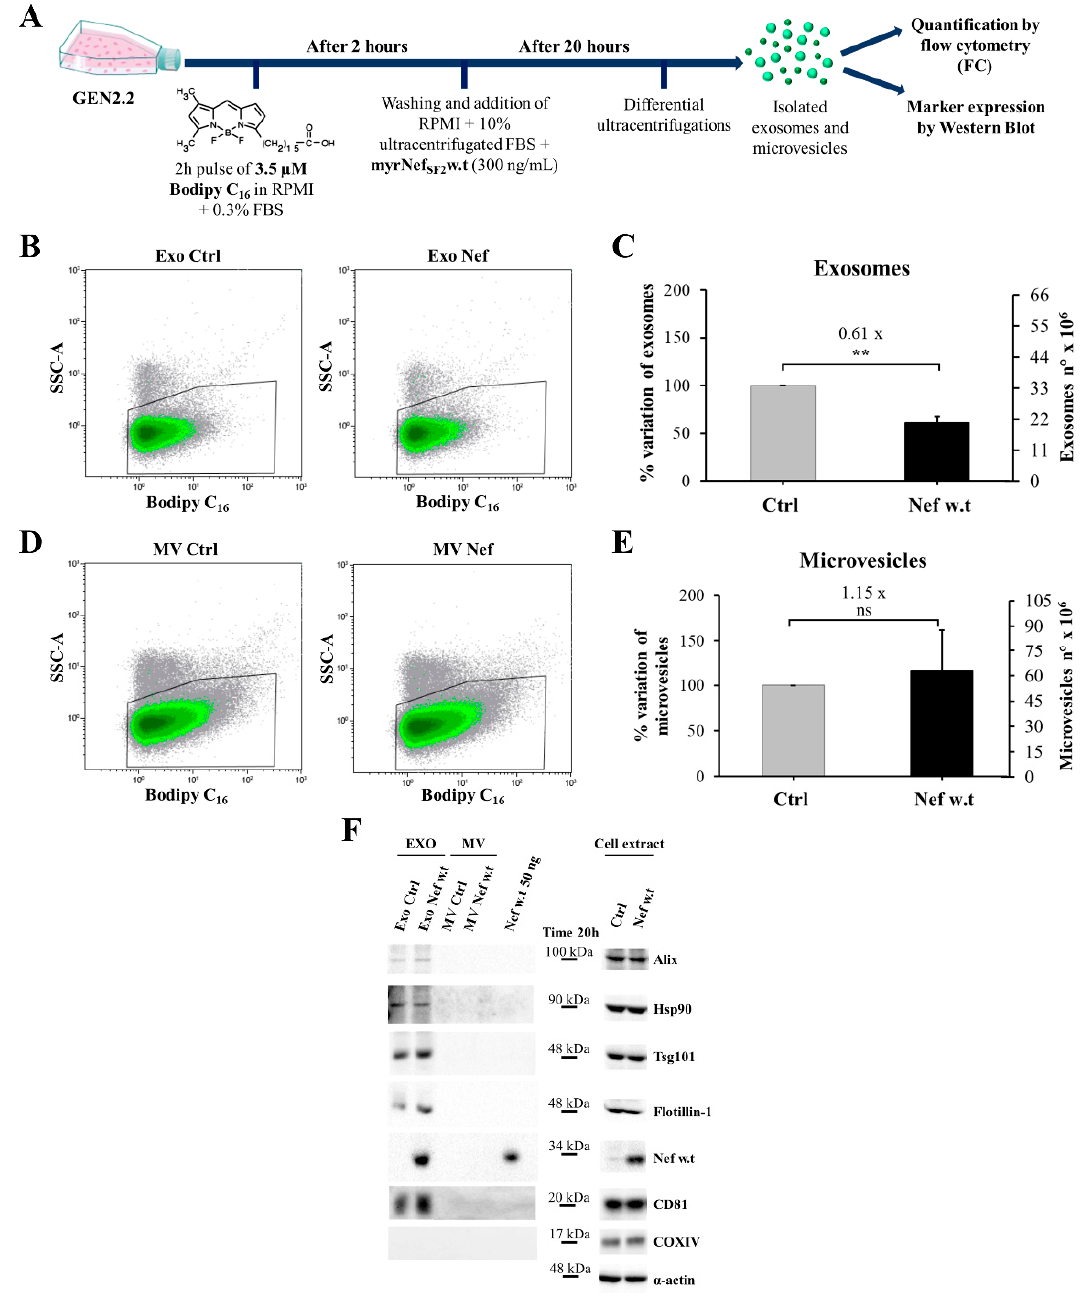
Figure 11. HIV-1 myrNef SF2 protein affects the exosome but not the microvesicle production by GEN2.2 cells and is found associated with the exosomal fraction. ( A ) Workflow of isolation of fluorescent exosomes and microvesicles from GEN2.2 cells treated with Nef protein. A total of 10 7 GEN2.2 cells were seeded in 75 cm 2 flask and treated for 2 h with 3.5 µ M of Bodipy C 16 in 5 mL of complete medium supplemented with 0.3% FBS. Then, cells were washed, and 12 mL of fresh medium supple- mented with 10% ultracentrifugated FBS containing or not containing 300 ng/mL of myrNef SF2 w.t were added. After 20 h, media were harvested and underwent differential ultracentrifugations to isolate exosomes (Exo) and microvesicles (MV). ( B , D ) Isolated fluorescent vesicles were counted through FC by plotting fluorescence at 525/40 nm (Bodipy C 16 ) versus log scale side scatter (SSC-A). The number of exosomes ( B ) or microvesicles ( D ) was registered in the rectangular region, as reported in Materials and Methods. ( C , E ) Histograms show the mean total number of fluorescent exosomes and microvesicles normalized to an equal number of cells. Values are expressed as mean ± S.D.